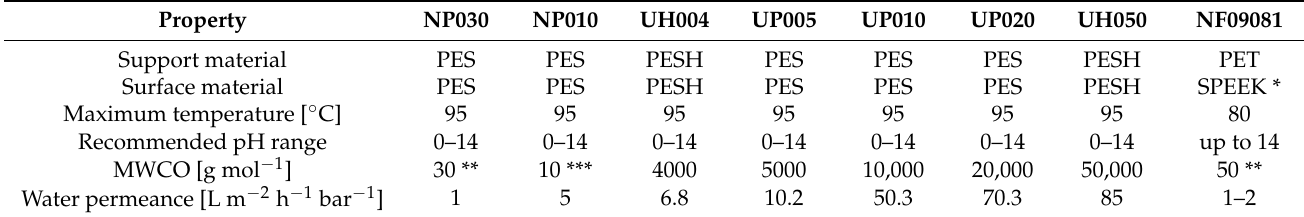
Table 2. Membrane properties given by the